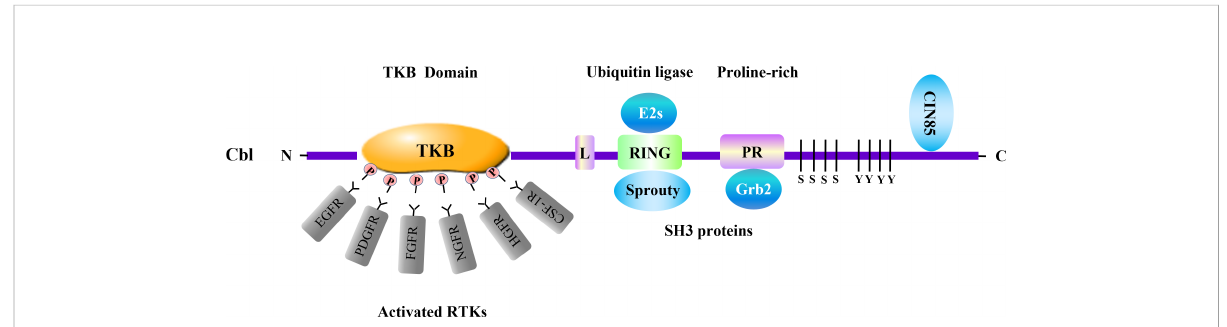
FIGURE 1 Cbl and adaptor proteins in negative regulation of RTKs. Cbl acts as a ubiquitin ligase involved in negative regulation of multiple RTKs. The Cbl protein consists of several domains which associate with distinct signaling transducers. Among them, the tyrosine kinase binding (TKB) domain binds to various activated RTKs. The RING- fi nger (RING) domain, which is crucial for the enzymatic activity of Cbl, interacts with adaptor protein Sprouty. Cbl RING fi nger domain can associate with E2 ubiquitin-conjugating enzymes (E2s) including Ubc4 and UbcH7. The proline-rich region (PR) serves as binding site for SH3-containing proteins such as Grb2. The SH3 domain of CIN85 can interact with the distal carboxyl terminus of Cbl. These molecules are involved in RTKs regulation conducted by Cbl. L,